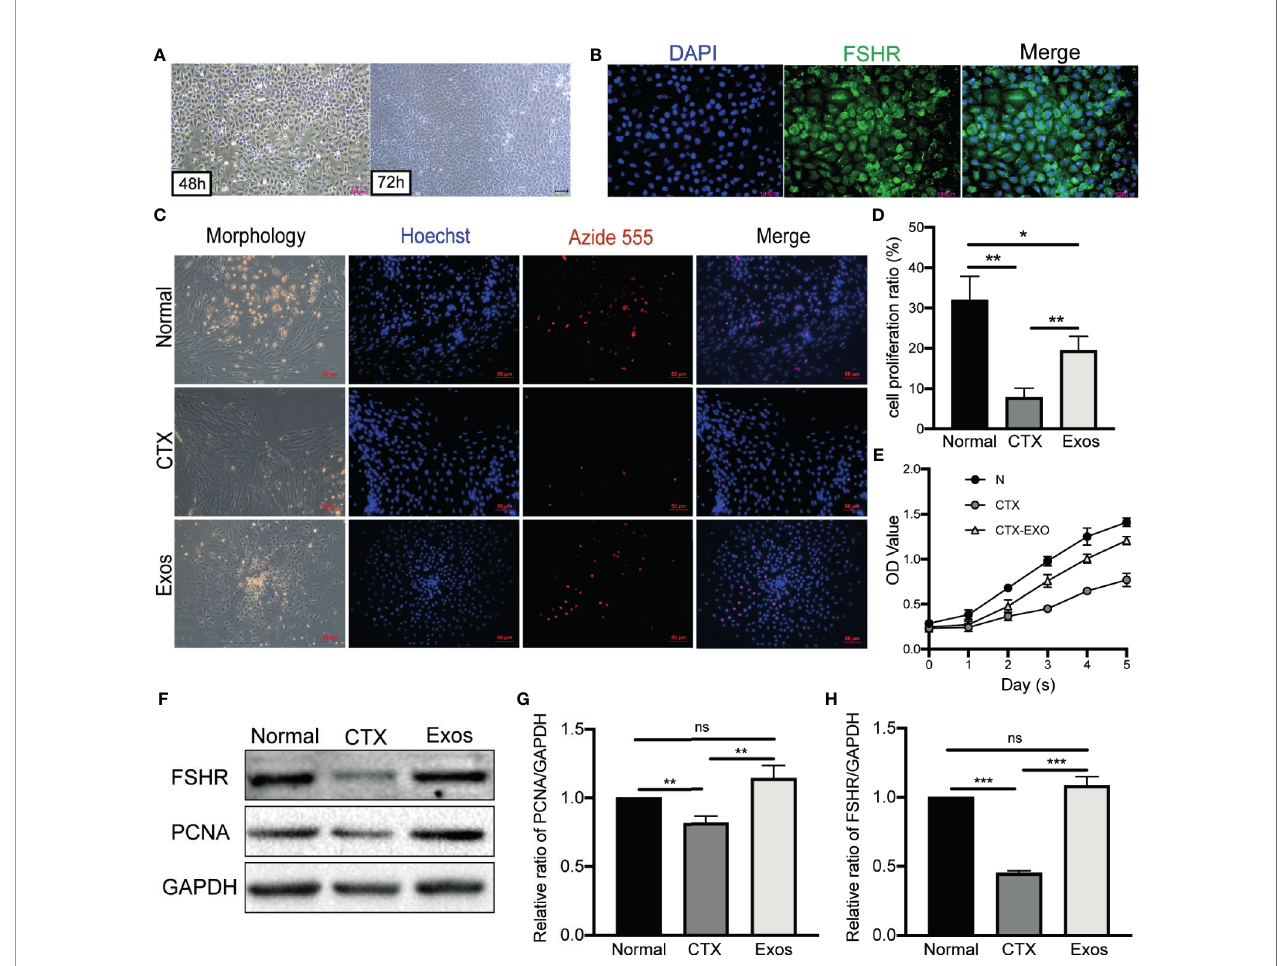
FIGURE 2 | Morphology and identi fi cation of GCs and therapeutic effects of hUCMSC-Exos in CTX-damaged GCs. (A) Morphologies of mouse ovarian GCs after isolation at 48 h and 72 h. Scale bar: 200 m m. (B) Identi fi cation of GCs by FSHR immuno fl uorescence. Scale bar: 100 m m. (C) EdU assay showed hUCMSC-Exos promoted the proliferative of GCs; cell nuclei were stained blue, while cells with proliferation activity were stained red. Scale bar: 50 m m. (D) Proliferation ratio of GCs was analyzed through the EdU assay. (E) Effects of hUCMSC-Exos on GCs viability were assessed by the CCK-8 assay from day 0 to day 5. (F) Representative immunoblots of PCNA and FSHR, using GAPDH as the reference. Quanti fi cation of protein expression revealed that exosomal treatment increased the expression levels of (G) PCNA and (H) FSHR. Data are presented as the mean ± SD. * p < 0.05, ** p < 0.01, *** p < 0.001, ns, no signi fi cance. Data are representative of three independent experiments in each